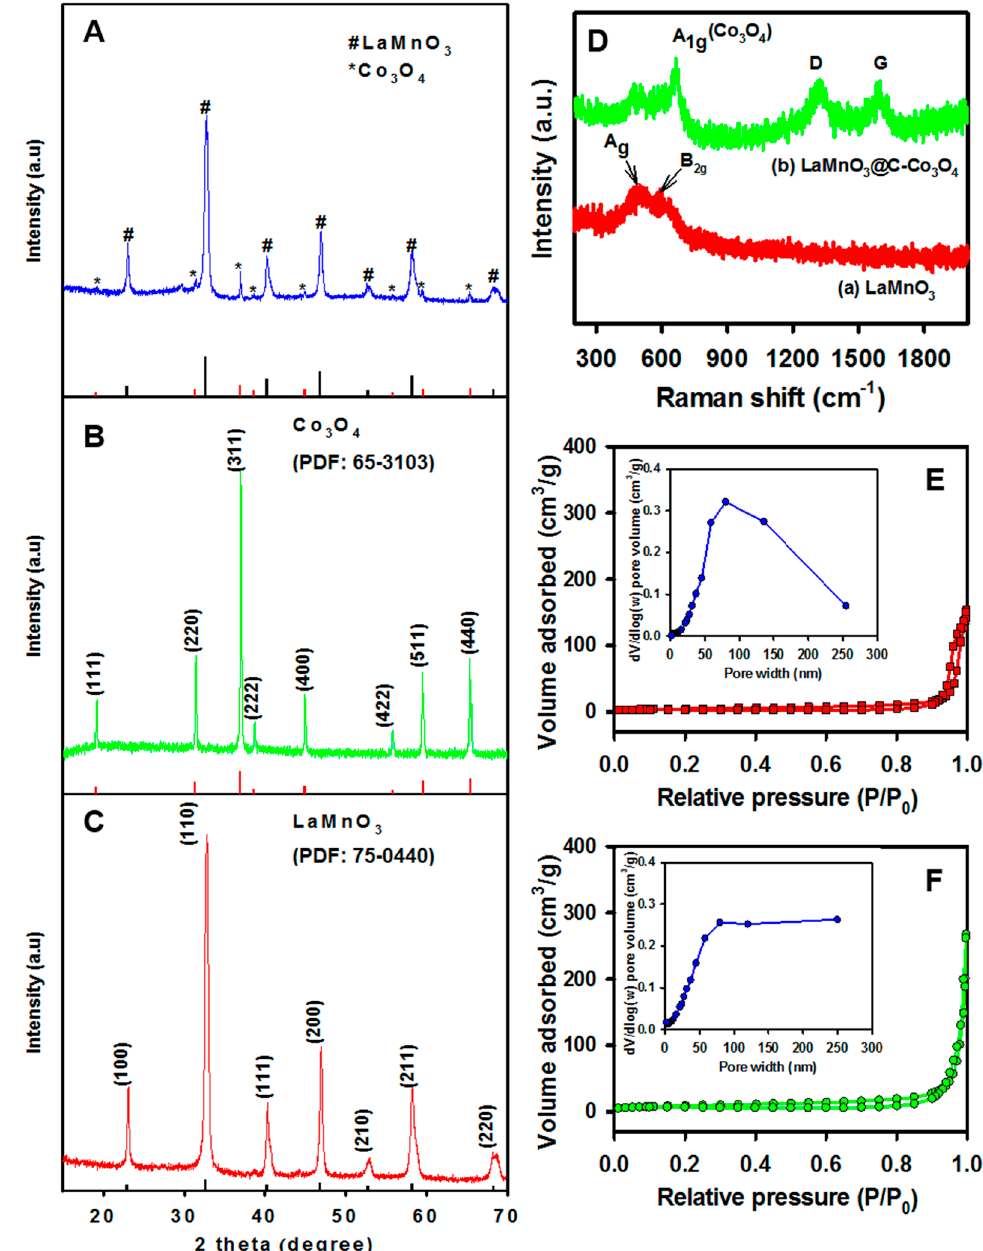
Figure 4. XRD pattern, ( A ) LaMnO 3 @C-Co 3 O 4 composite, ( B ) Co 3 O 4 , and ( C ) LaMnO 3 , ( D ) Raman spectra of LaMnO 3 ( a ) and LaMnO 3 @C-Co 3 O 4 composite ( b ). BET adsorption-desorption isotherm curves of LaMnO 3 ( E ), and LaMnO 3 @C-Co 3 O 4 composite catalyst ( F ).